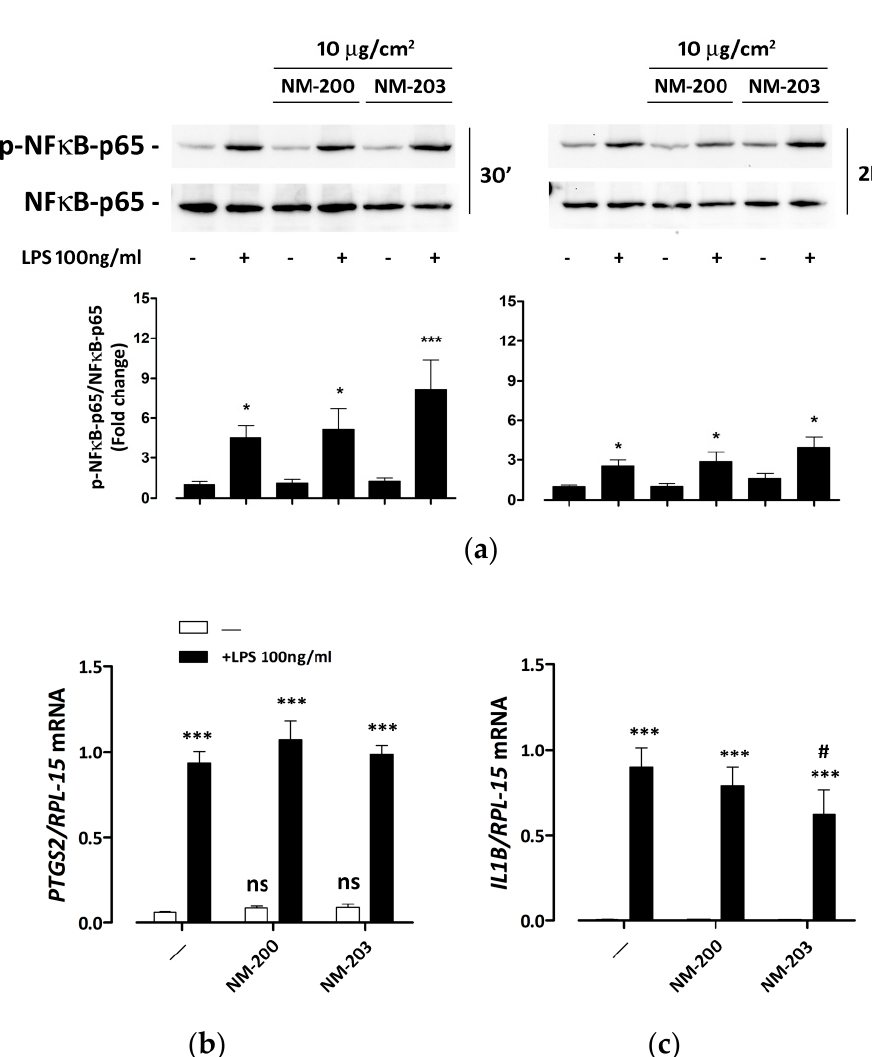
Figure 4. NF κ B activation and induction of pro-inflammatory genes in ASNP-pretreated macrophages. THP-1 cells were incubated for 24 h with NM-200 or NM-203. The incubation was then prolonged with or without LPS. The expression of phosphorylated and total NF κ B-p65, used as an activation marker and a loading control, respectively, was determined after (left, a ) 30 min and (right, a ) 2 h, while the expression of the mRNAs of ( b ) PTGS2 or ( c ) IL1B was measured after 24 h. In ( a ), representative experiments are shown along with the means of the relative abundance of p-NF κ B-p65 (bottom graph charts) protein ± SD (n = 3). * p < 0.05; *** p < 0.001 vs. untreated cells, one-way ANOVA. In panels b and c , data represent means of two independent determinations performed in duplicate ± SD. *** p < 0.001 vs. the same condition without LPS; # p < 0.05 vs. cells treated with LPS alone, two-tail t-test for unpaired data.